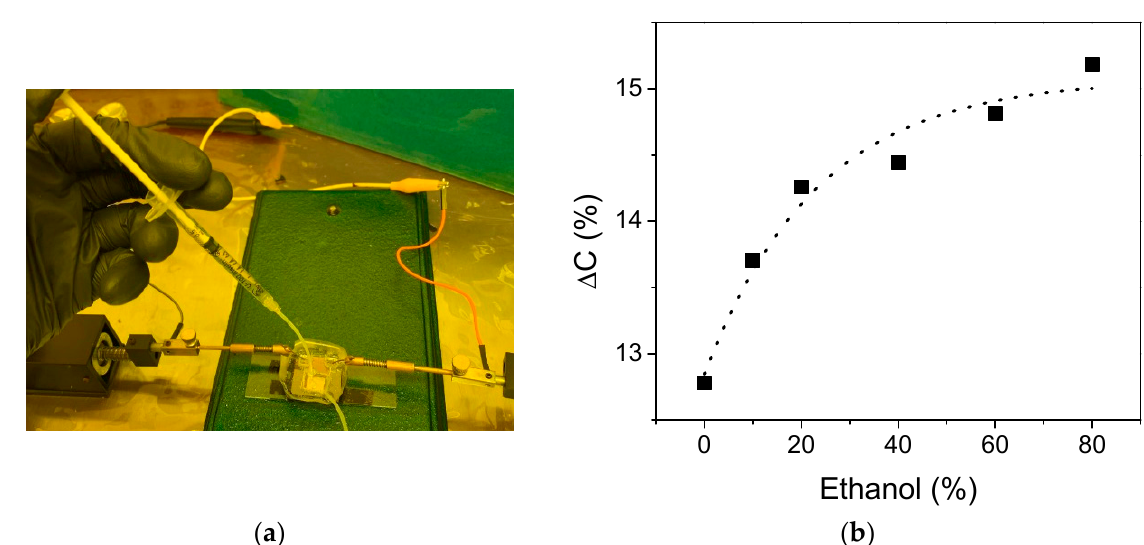
Figure 6. Implementation of the CSC as a liquid sensor device. ( a ) Physical implementation set-up. ( b ) Physical measurement of the capacitance change ( Δ C ) vs. ethanol concentration aqueous solution.